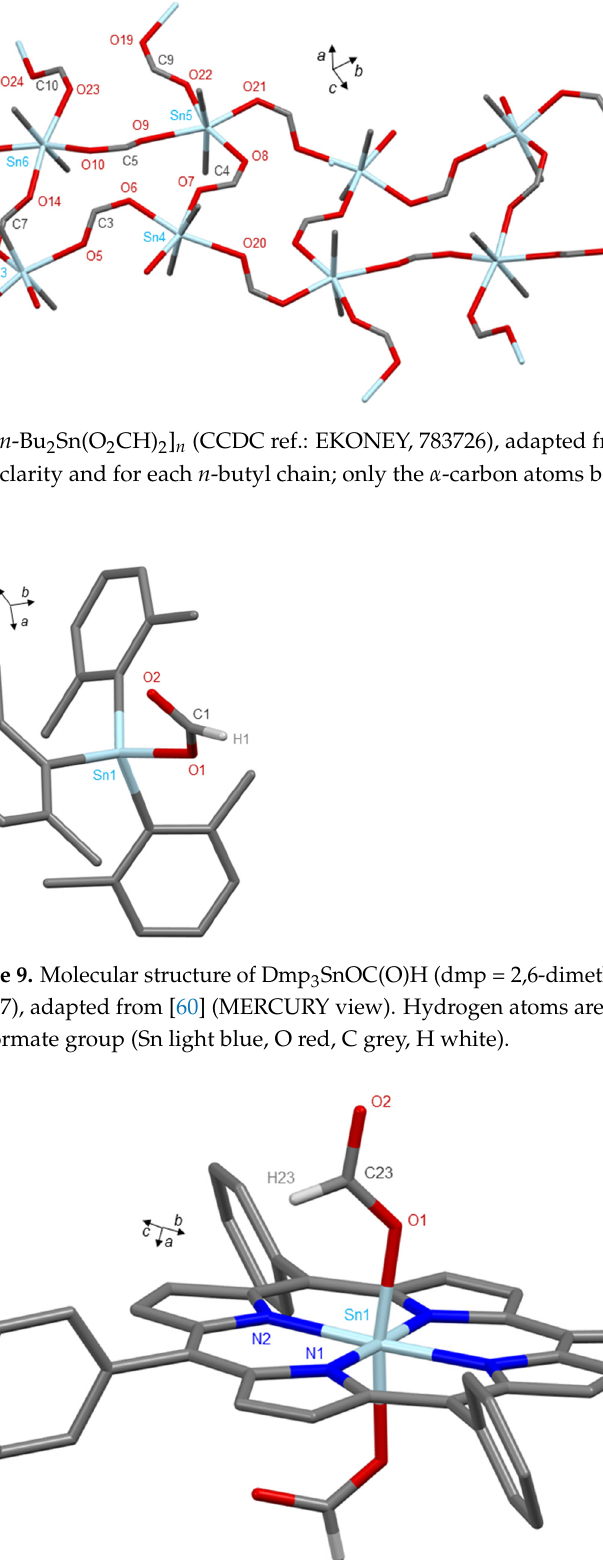
Figure 10. Molecular structure of Sn(TPP)[(OC(O)H] 2 (TPP = dianion of 5,10,15,20-tetraphenylpor- phyrin) (CCDC ref.: EPAZAX, 711428), adapted from [61] (MERCURY view). Hydrogen atoms are omitted for clarity except that of the formate group (Sn light blue, O red, N dark blue, C grey, H white).